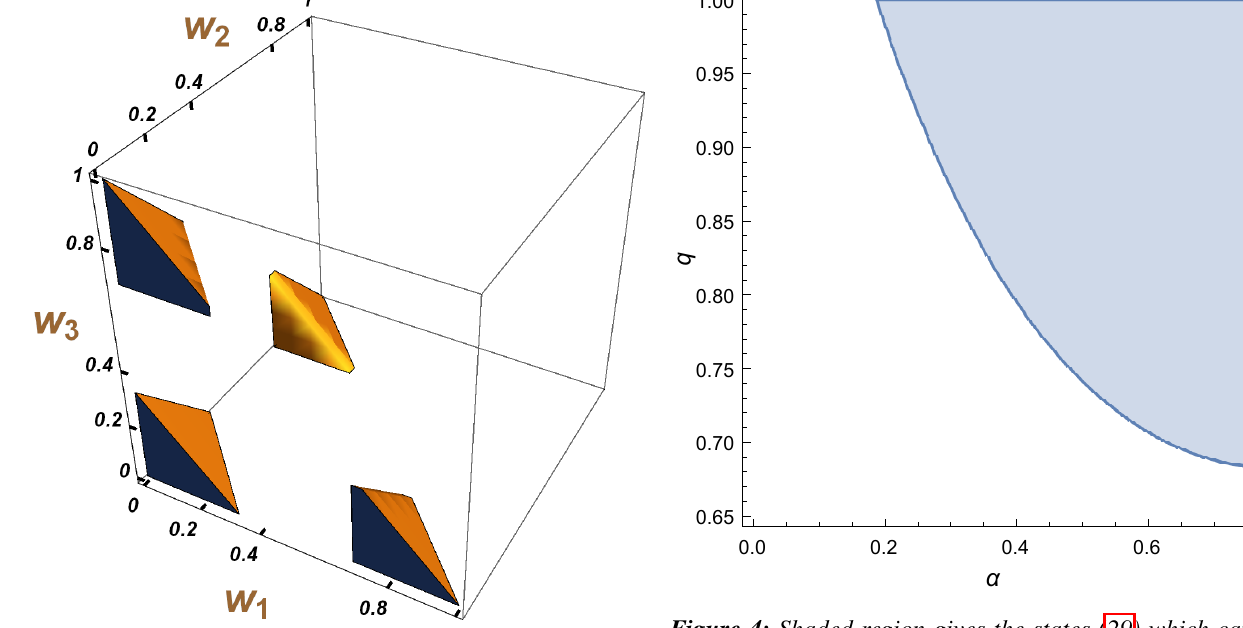
Figure 4: Shaded region gives the states (29) which can be used for secure key